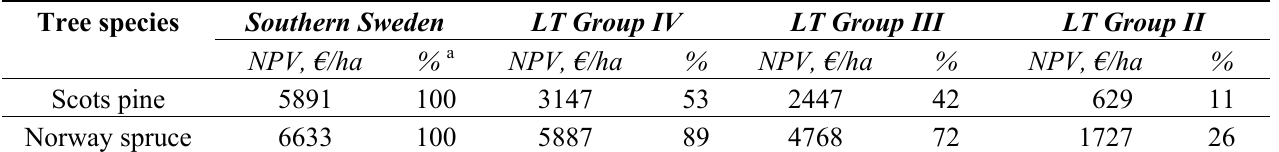
Table 5. Net present values (NPVs), from average statistical conifer stands in Lithuania (LT) applying Swedish versus Lithuanian MARAs in forest Groups II–IV. Tree